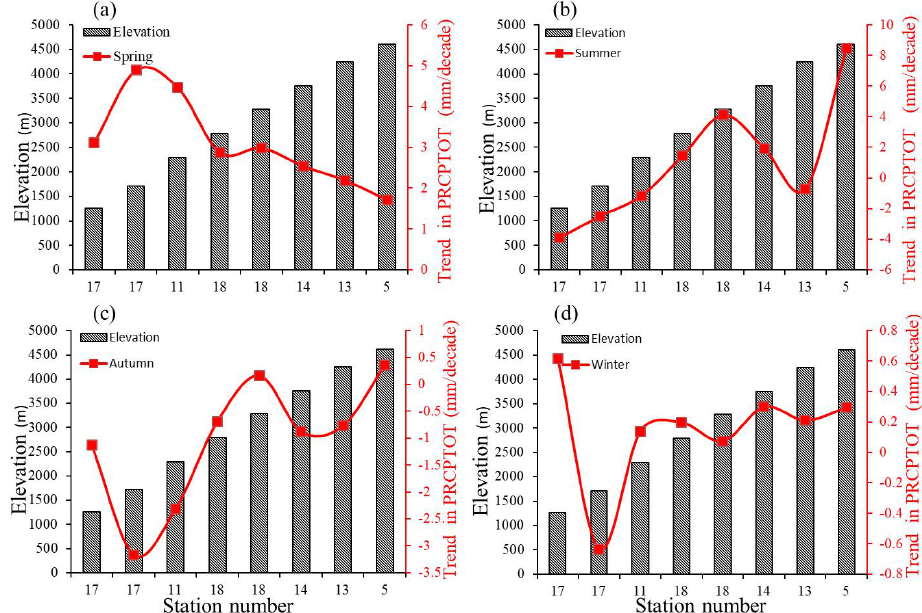
Figure 8. Elevation dependence of seasonal total precipitation trends (mm/decade) (( a ) spring; ( b ) summer; ( c ) autumn; ( d ) winter) in the TP and TPS during 1971–2017. (The numbers in horizontal axis represent the stations in each 500 m elevation band, and trend magnitude is plotted on the y axis, the trends are the means over individual elevation bins).